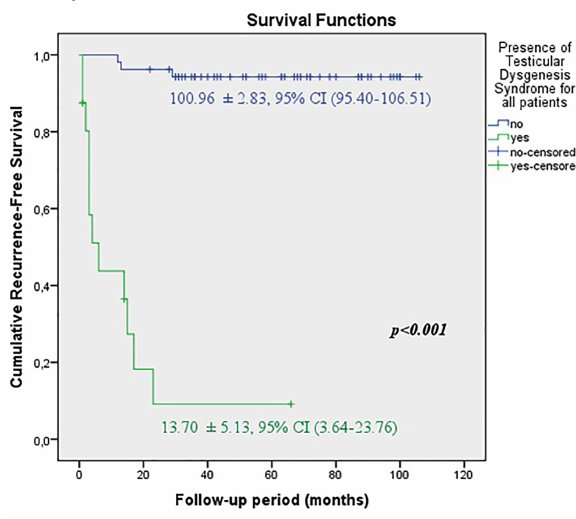
Figure 2C - Kaplan-Meier plots of cancer-specific survival according to presence of Testicular Dysgenesis Syndrome for all patients.